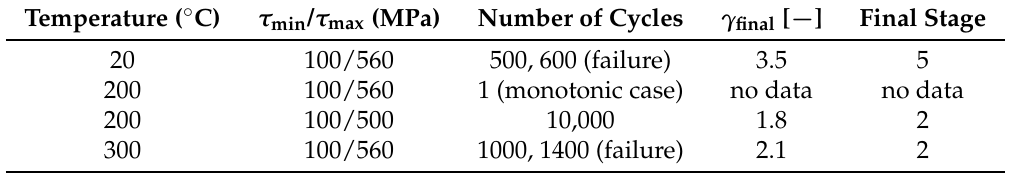
Table 9. Synthesis for the cyclic shear tests. The same maximal stress of 560 MPa was considered for 20 ◦ C and 300 ◦ C. For the test at 200 ◦ C, such a maximum stress would have been too close to the monotonic failure stress (Figure 8). A few cycles would have led to the failure of the specimen, which explains the choice of a lower maximum shear stress (500 MPa rather than 560